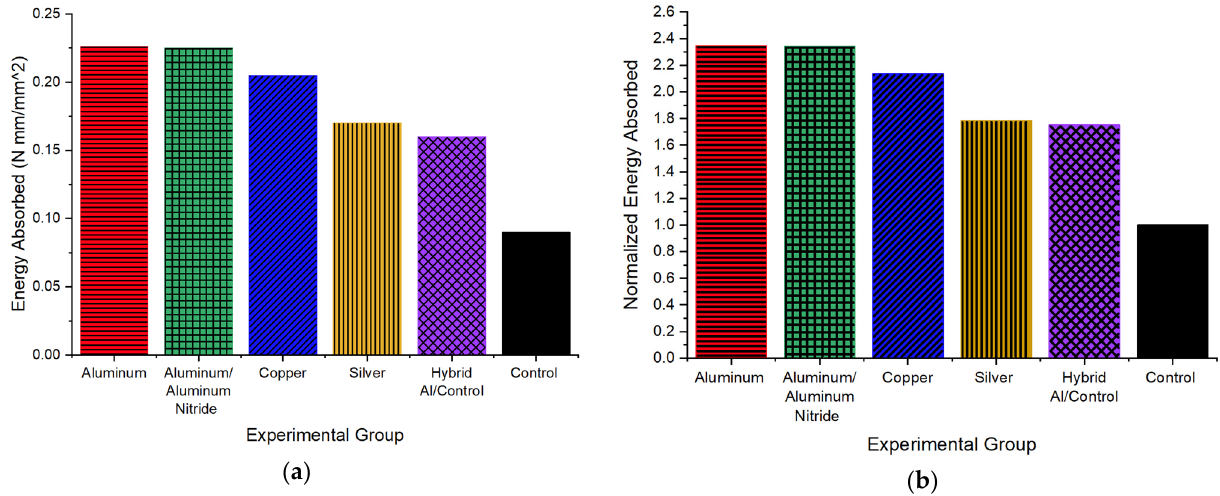
Figure 13. Energy absorbed at 200 N transverse pre ‐ tension ( a ) energy absorbed ( b ) normalized energy absorbed with respect to control.